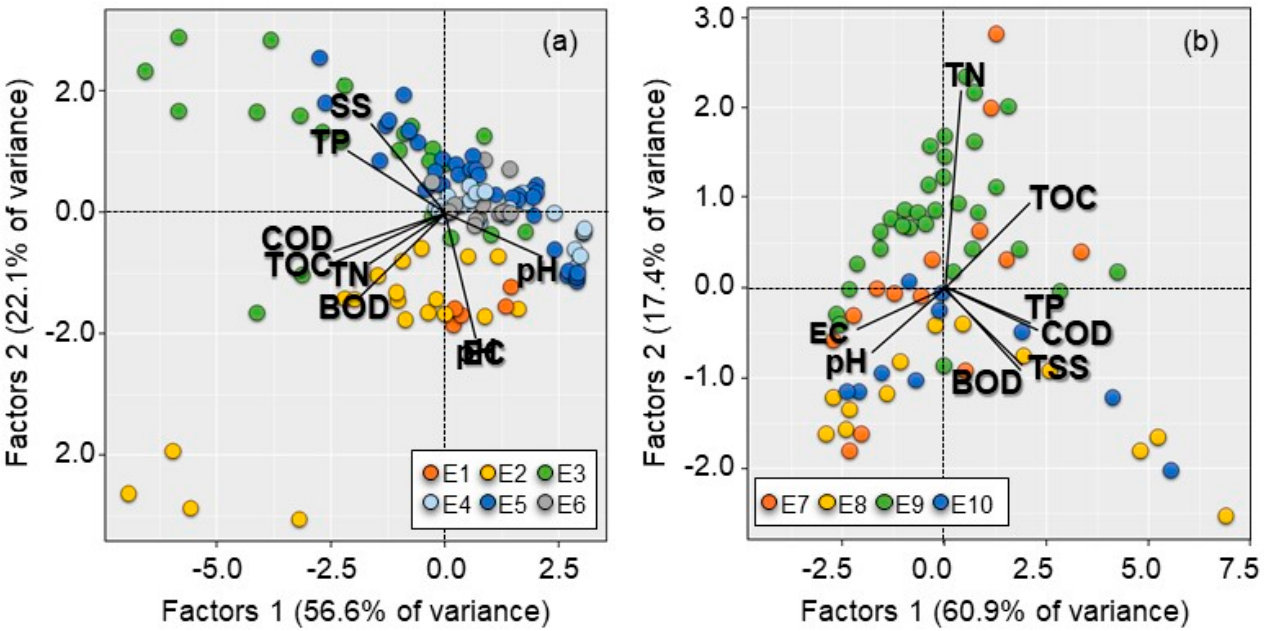
Figure 6. Biplot of principal components for observed water quality parameters in ( a ) spring (E1 − E6) and ( b ) summer (E7 − E10) in the immediate post ‐ fire period. EC: electrical conductivity, BOD: